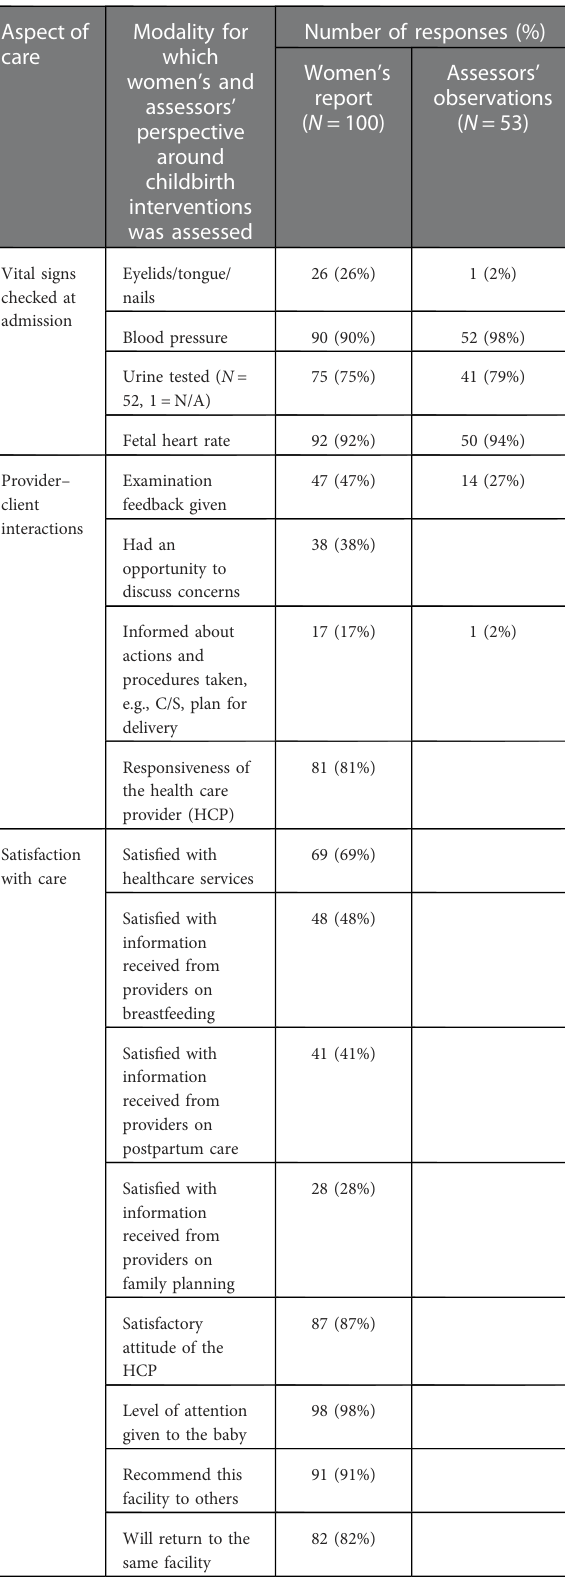
TABLE 1 Women ’ s demographic characteristics.